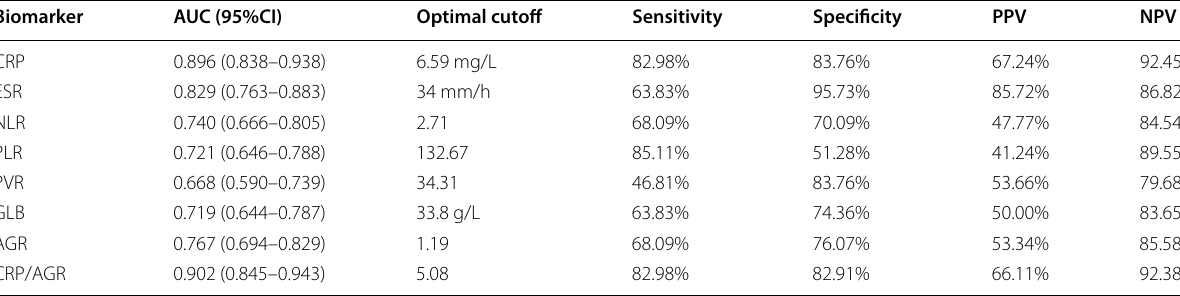
AUC area under the curve, PPV positive predictive value, NPV negative predictive value